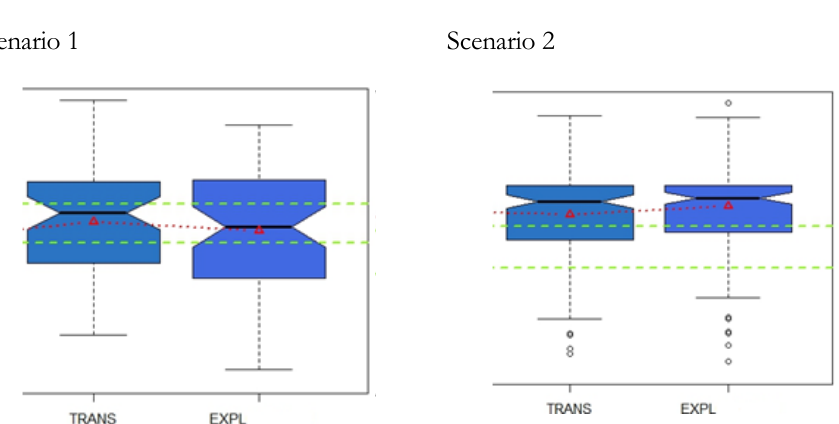
Figure 4. Summary of transformation and exploitation processes in the two scenarios’ enterprise